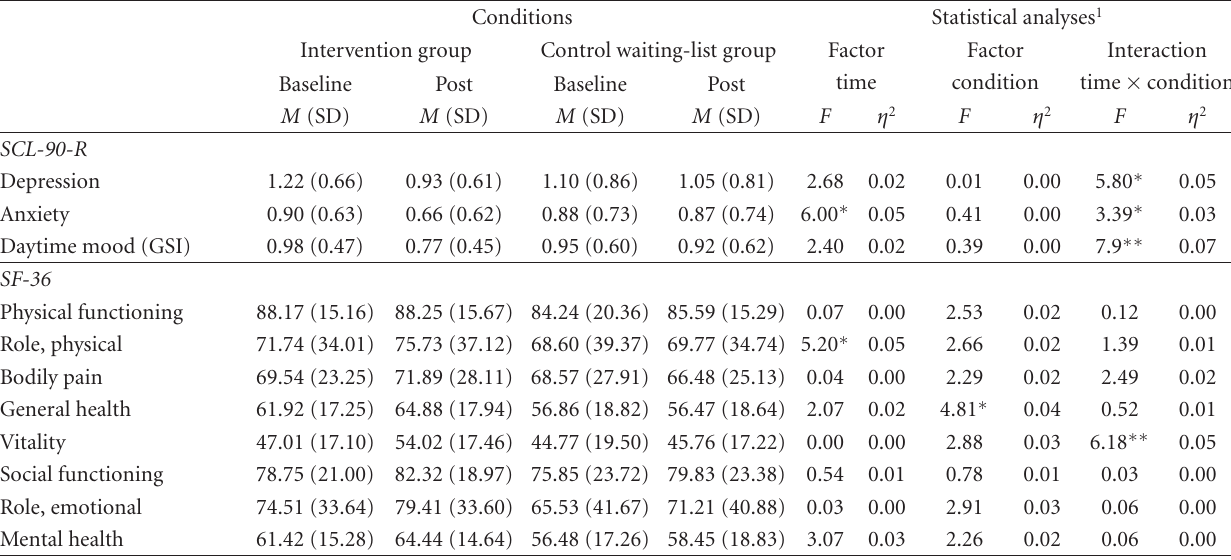
Table 3: Model estimated means ( M ), standard deviation (SD) and Time × Condition e ff ects for daytime mood, and quality of